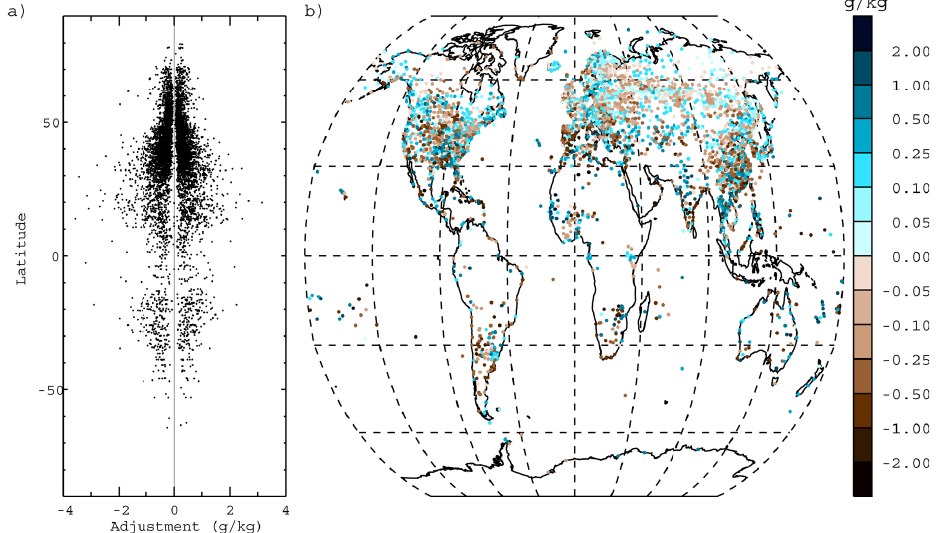
Fig. 4. Distribution of adjustments made and their magnitude during the pairwise homogenisation process: (a) adjustments by latitude; (b) largest adjustments for each station. Note non-linear colour